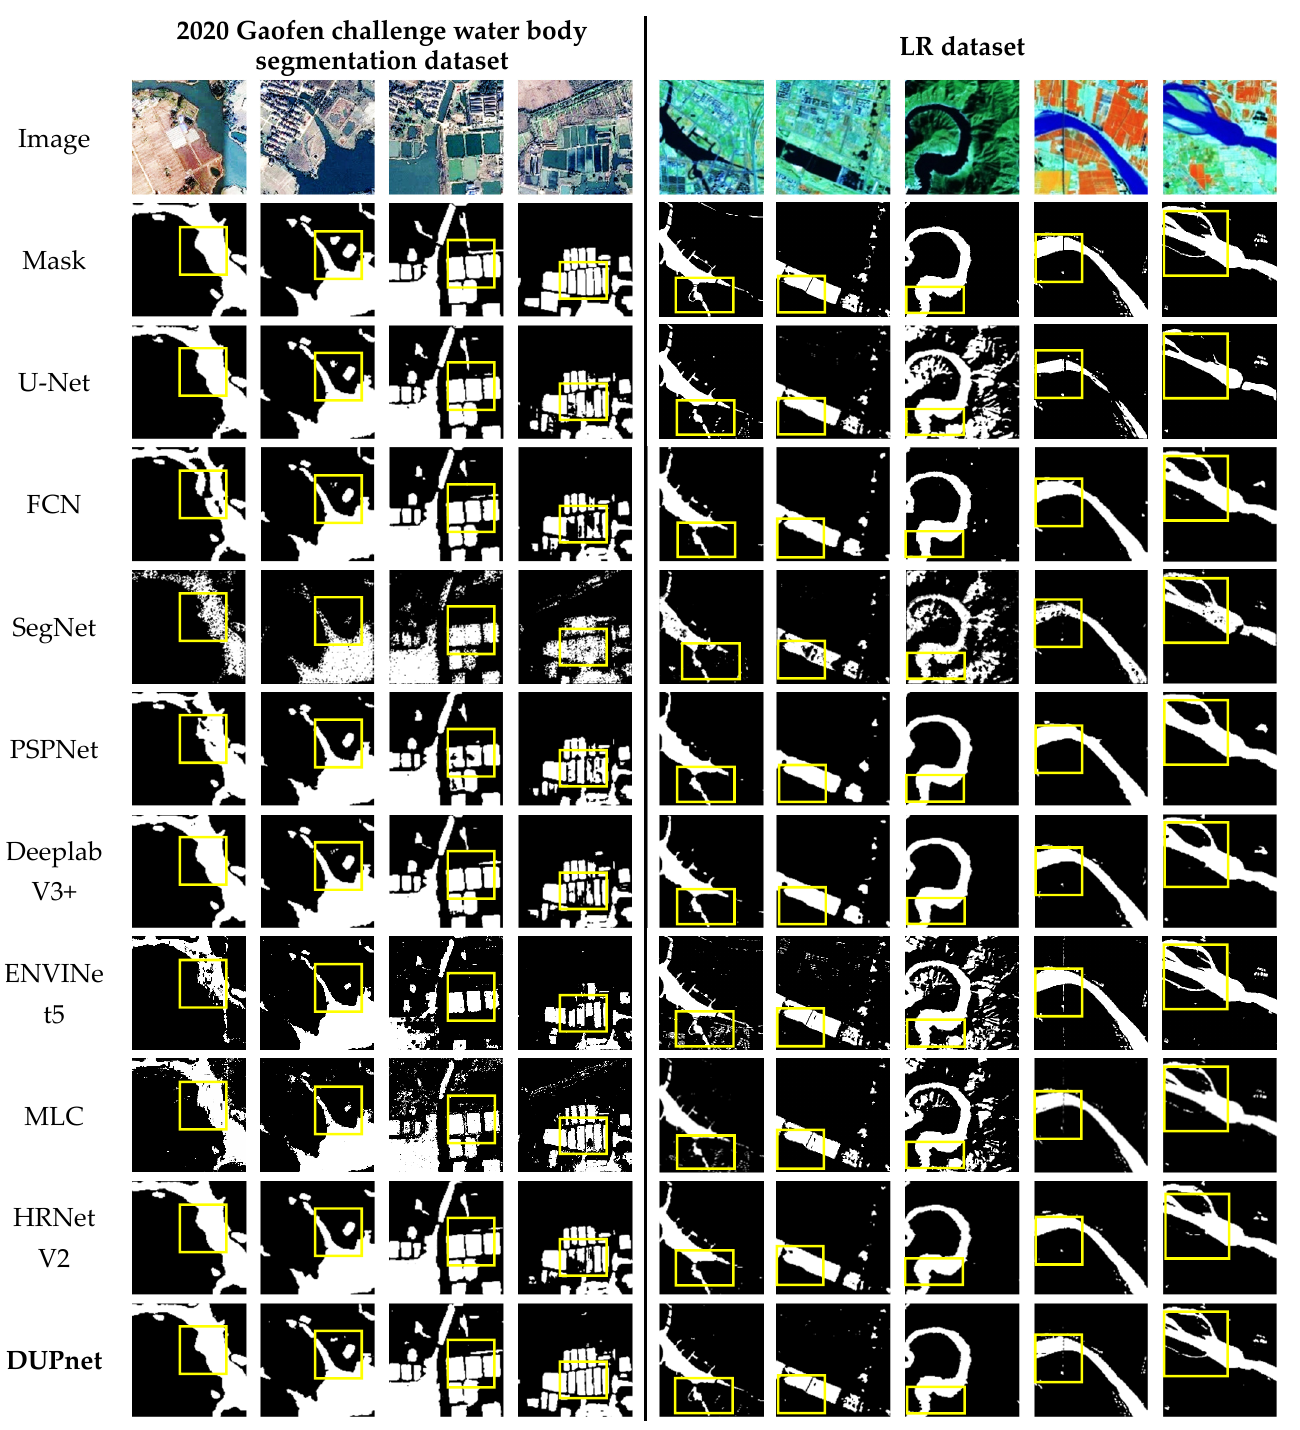
Figure 12. Qualitative evaluation with state-of-the-art methods on the 2020 Gaofen challenge water body segmentation dataset and the LR dataset.